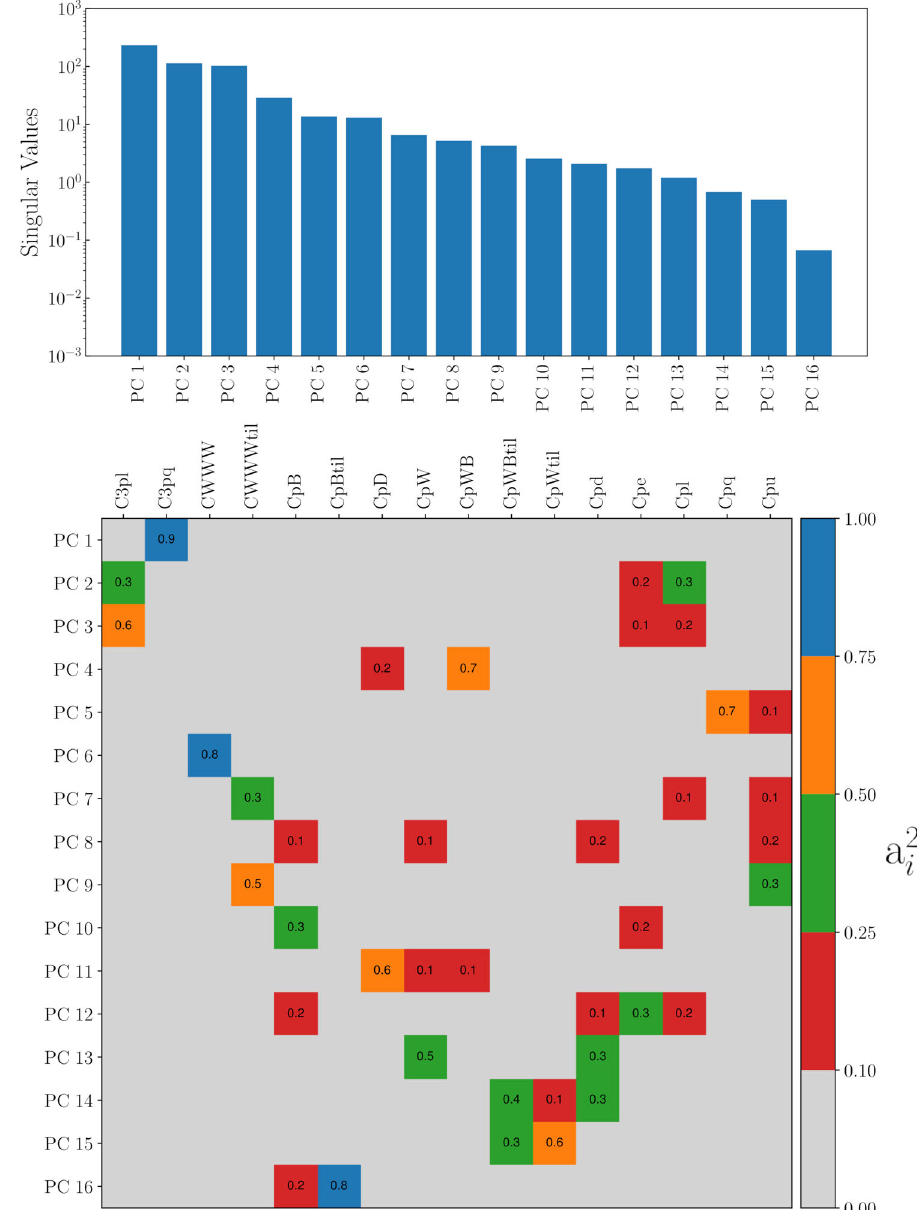
Fig. 15 Results of the principal component analysis applied to the baseline VBS+diboson dataset. The upper panel shows the distribution of singular values, while the lower one displays the squared values for the coefficients a ki of the principal components in Eq.